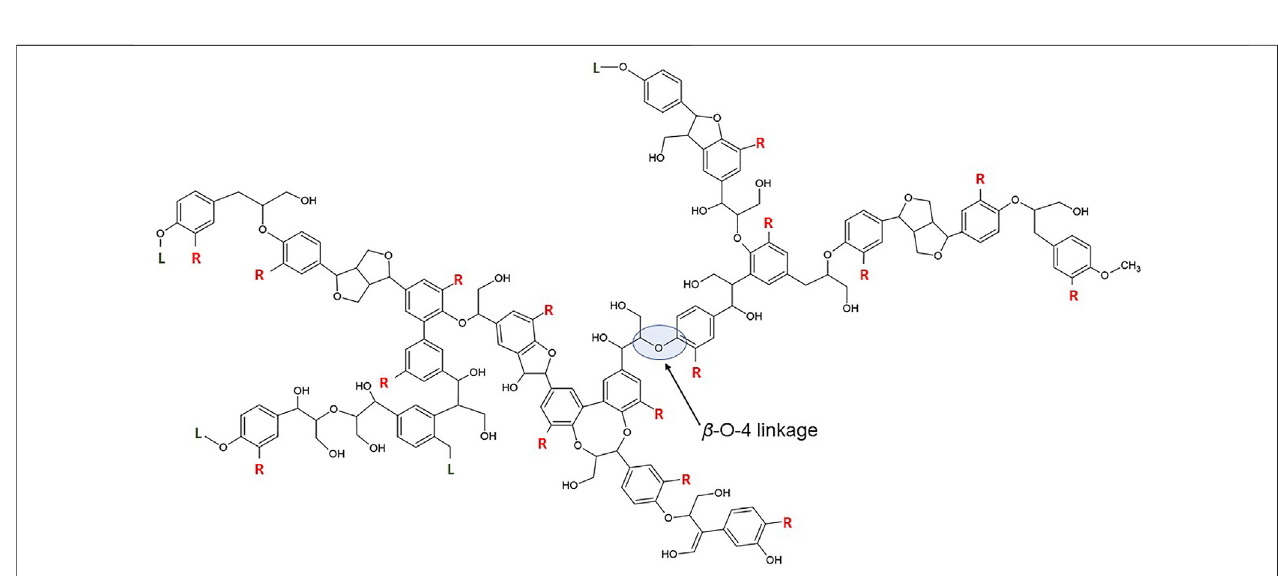
FIGURE 2 | Chemical structure of lignin polymer. L, lignin molecules; R, H or -OCH 3 .